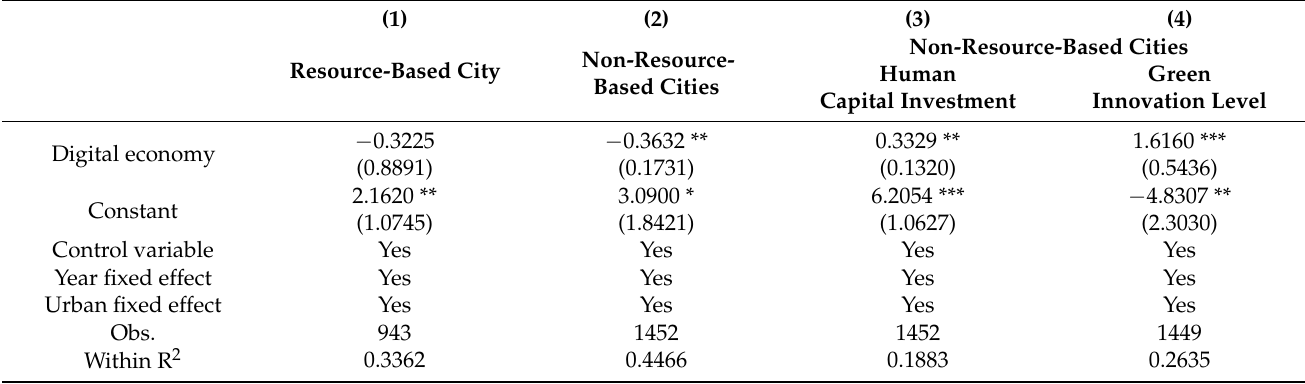
Table 10. Regression results of resource-based cities and non-resource-based